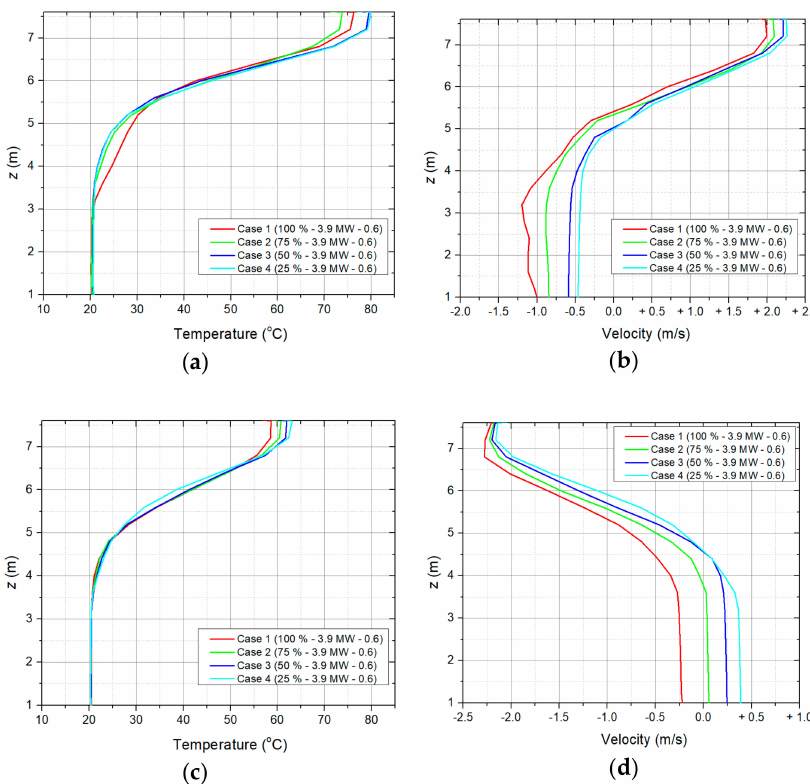
Figure 7. Temperature and velocity distribution in the tunnel: ( a ) temperature distribution at Y = 120; ( b ) velocity distribution at Y = 120; ( c ) temperature distribution at Y = 300 and ( d ) velocity distribution at Y =